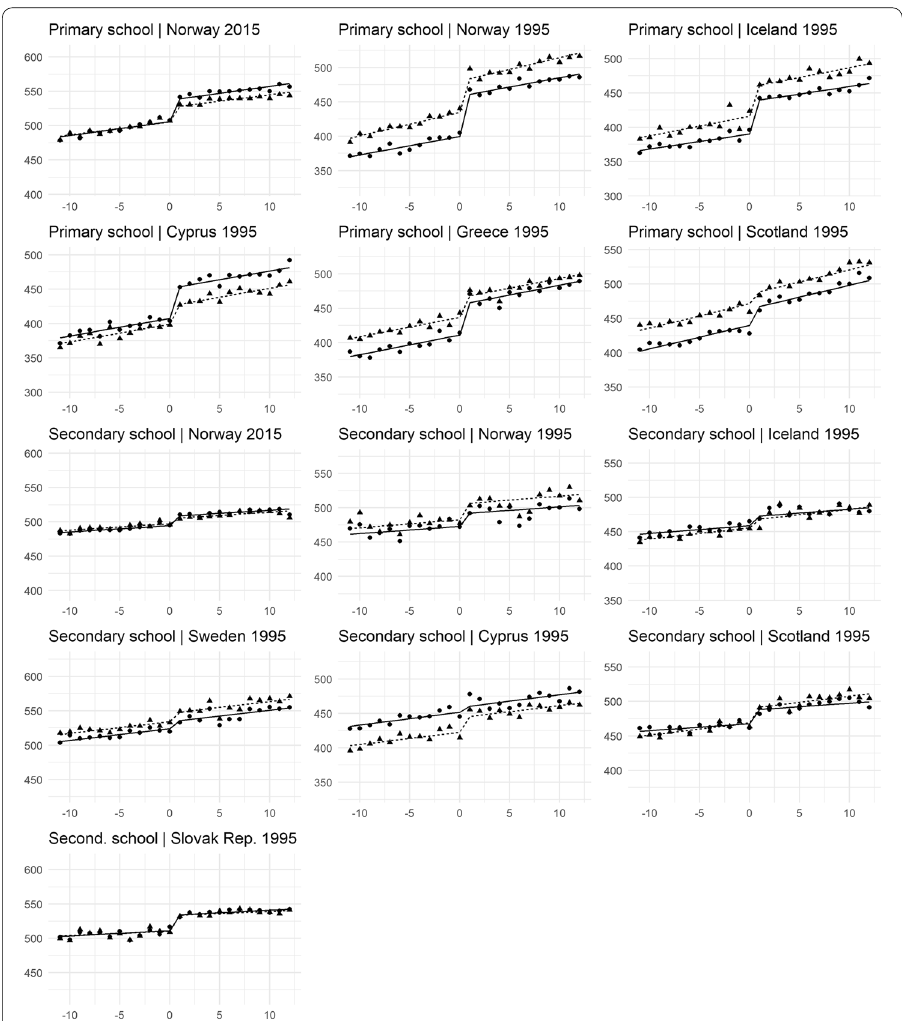
Fig. 3 Results of the regression discontinuity analyses with student-level focus. The figure displays achievement score (y-axes) means per month of age (x-axes) for mathematics (dots) and science (triangles) domains. The lines illustrate regression discontinuity results for mathematics (solid lines) and science (dashed lines). The slopes illustrate age effects. The regression discontinuities between age 0 (oldest students in = lower grade) and age 1 (youngest students in upper grade) illustrate the added-year effects across all = schools. The y-axes are centered around the samples’ overall mean achievement, with the scale limited to 100 points above and below those means. The findings are displayed numerically in Appendix B. The analyses